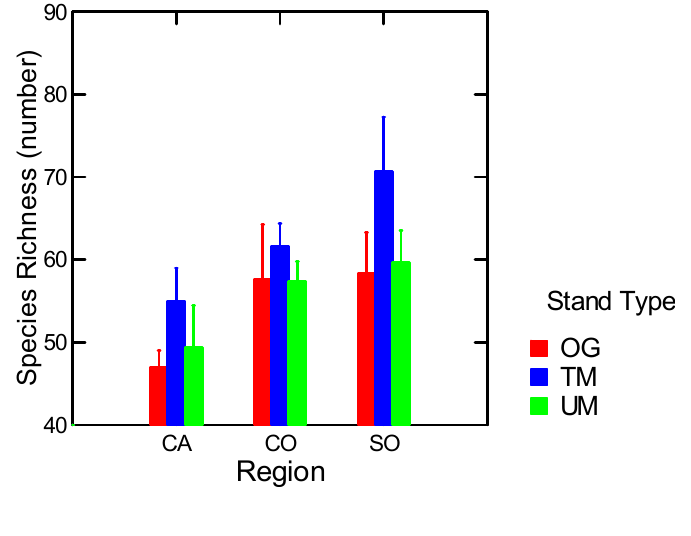
Figure 6. Species richness of epigeic macrofauna, by region and stand type. CA = Cascades; CO = Coast Range; SO = Siskiyous; Bars = standard errors.